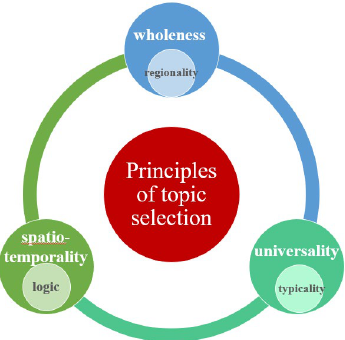
Figure 1 . Principles of topic selection.